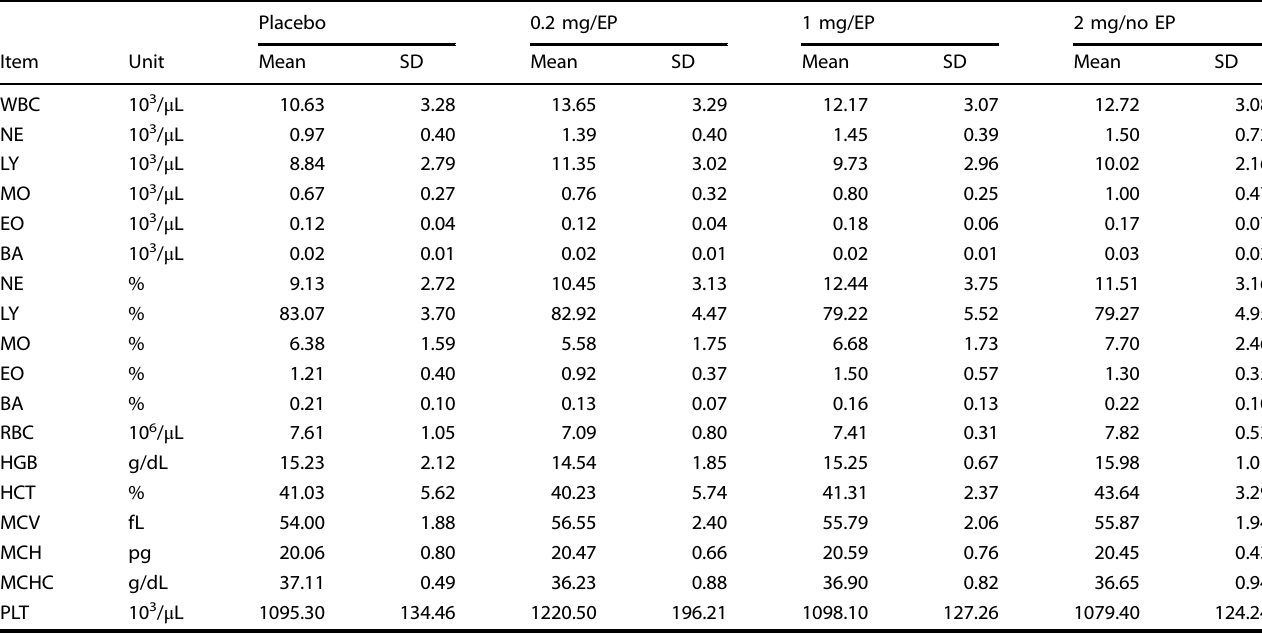
Table 2. Effect of DNA vaccination on hematology in a repeated-dose toxicity